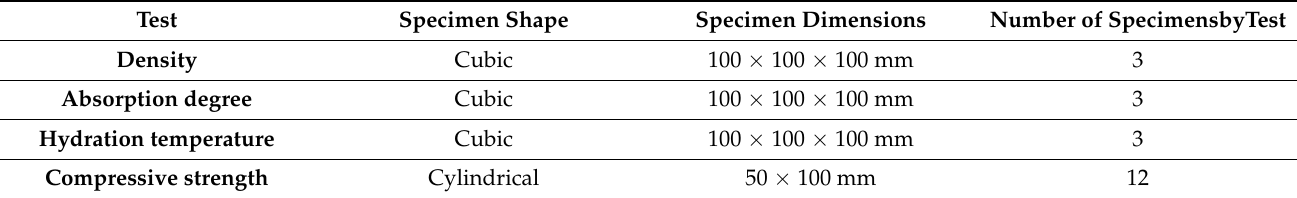
Table 4. Specimens shape and Figure 5. Flow time as function of water/gypsum plaster ratio.